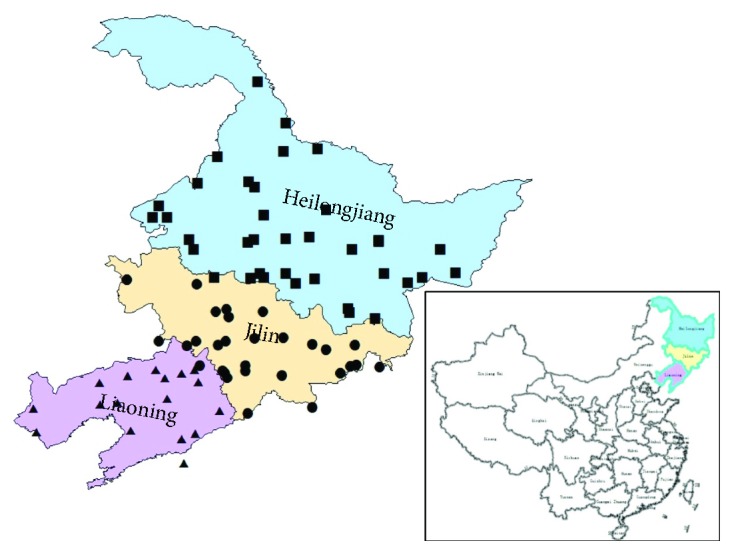
Geographic distribution map of wild soybean accessions in Northeast China. ■, ●, and ▲ represent the wild soybean core collections from Heilongjiang (HLJ), Jilin (JL), and Liaoning (LN), respectively.